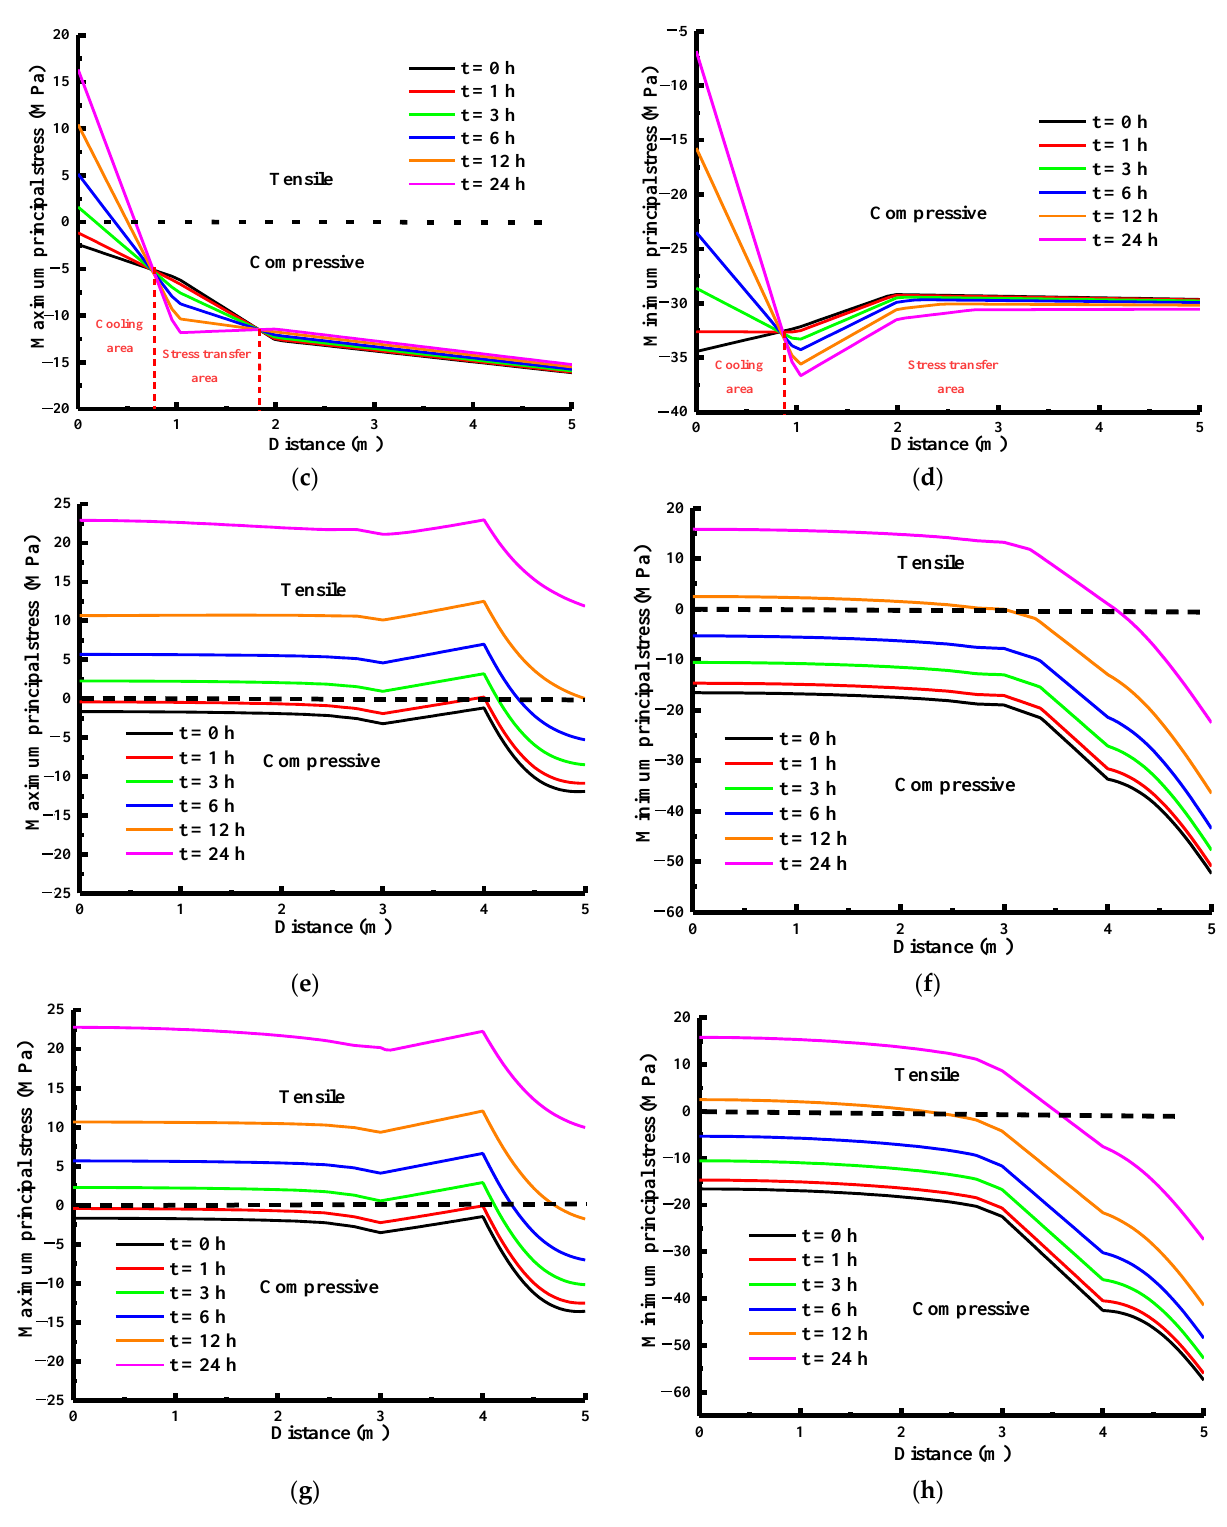
Figure 10. Variation in the maximum and minimum principal stresses for t = 0~24 h along 4 paths: maximum ( a ) and minimum ( b ) principal stresses along Path 1; maximum ( c ) and minimum ( d ) principal stresses along Path 2; maximum ( e ) and minimum ( f ) principal stresses along Path 3; and maxi-mum ( g ) and minimum ( h ) principal stresses along Path 4. Figure 10e,f show the curves of the maximum and minimum principal stresses of Path 3, respectively. Figure 10e shows that with the cooling of the tunnel, the maximum